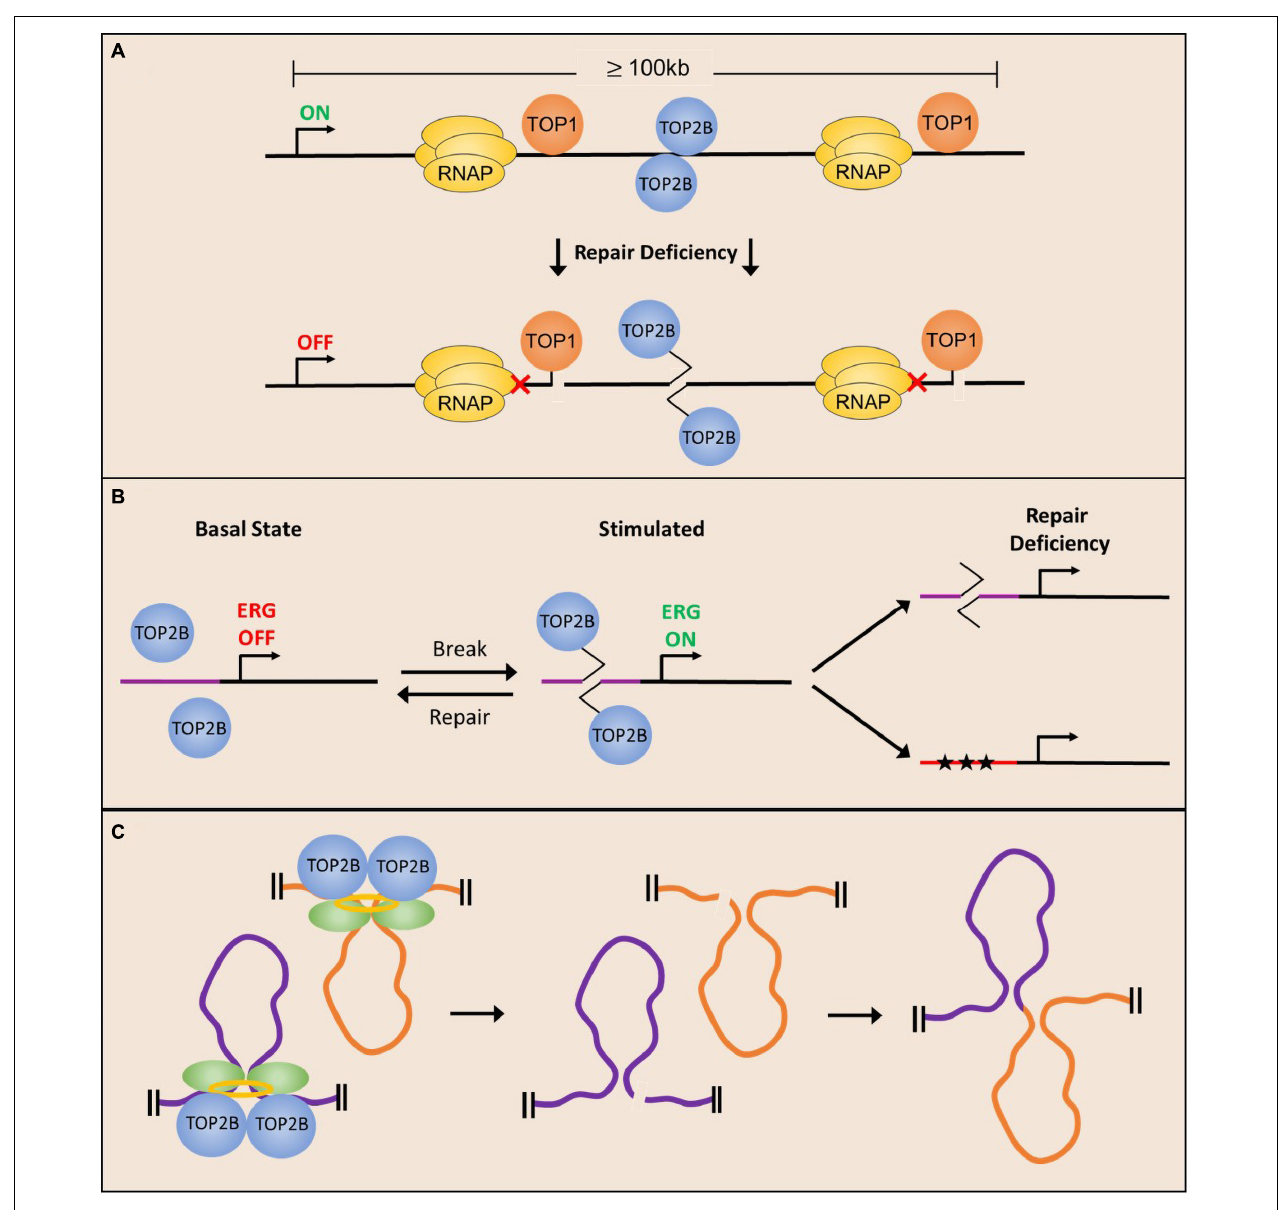
FIGURE 3 | Potential mechanisms underlying the development of neurological phenotypes due to deficient repair of topoisomerase-mediated lesions. (A) Long neuronal genes require topoisomerase activity to facilitate their expression and are therefore more likely to incur stochastic cleavage complex formation. Deficient repair of stalled cleavage complexes results in polymerase pausing and downregulation of long gene expression. (B) Neuronal stimulation facilitates the formation of TOP2ccs in the promoters of ERGs to facilitate their expression, and repair of the TOP2-mediated break restores basal conditions. Deficient repair can either cause delayed break repair or mutagenesis (stars) resulting in dysregulation of ERG expression. (C) TOP2-mediated DNA DSBs at chromatin loop anchors could lead to altered gene activity patterns in neurons and compromise neuronal